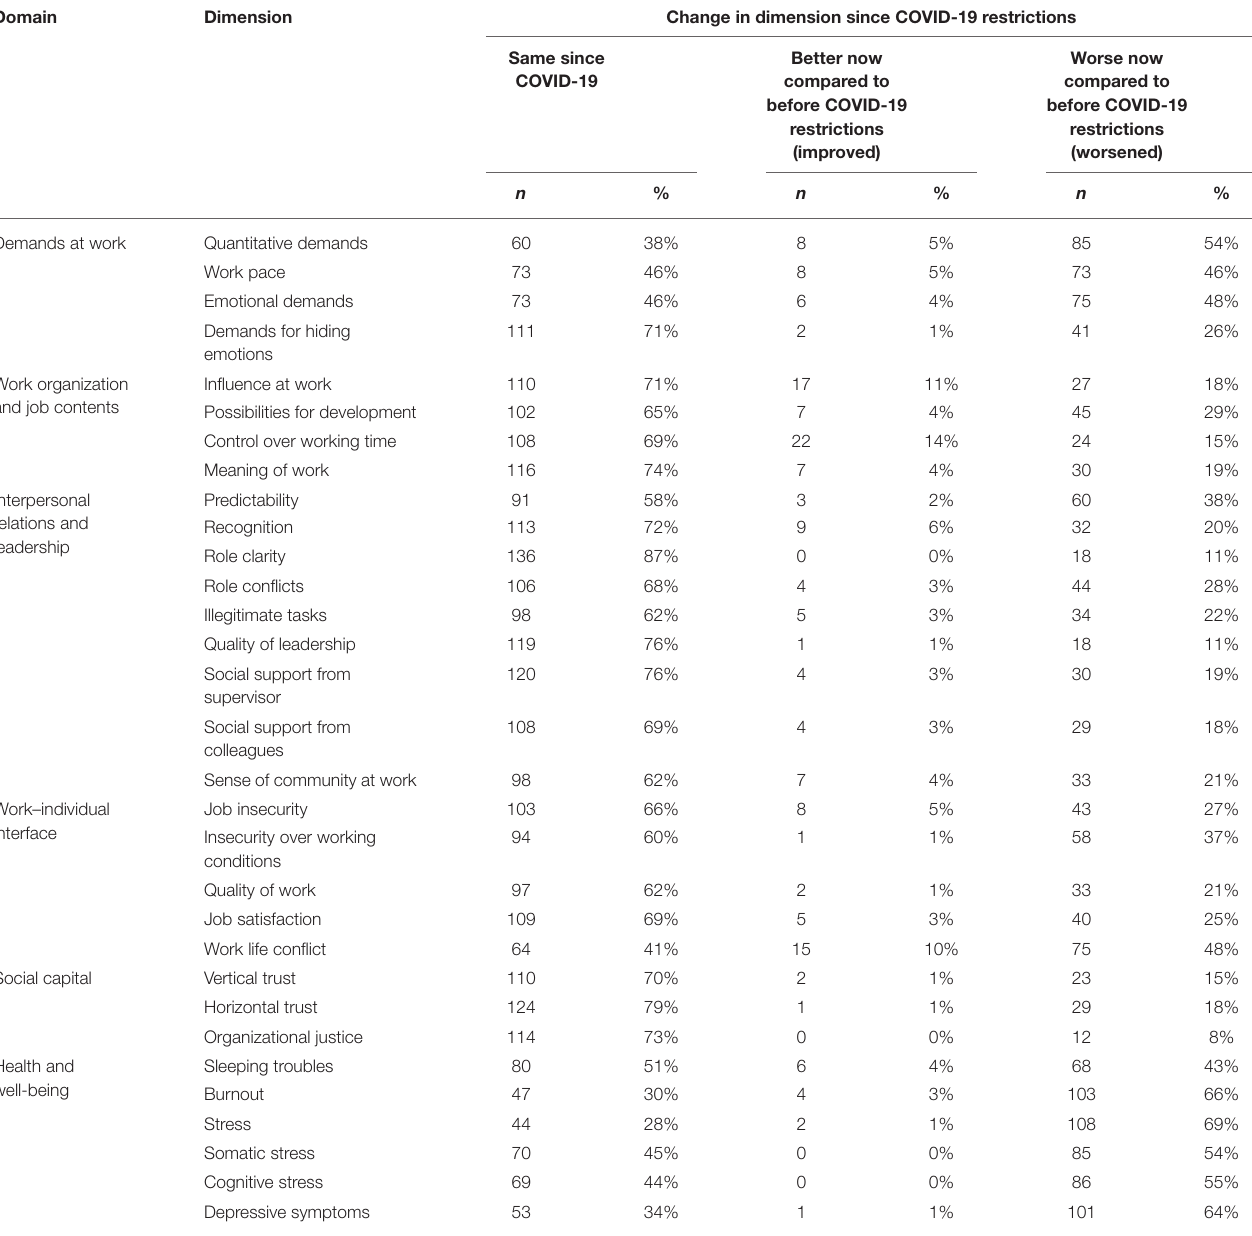
TABLE 4 | Number and proportion of respondents reporting the COPSOQ-III dimensions had improved, remained the same, or worsened, since COVID-19 restrictions.